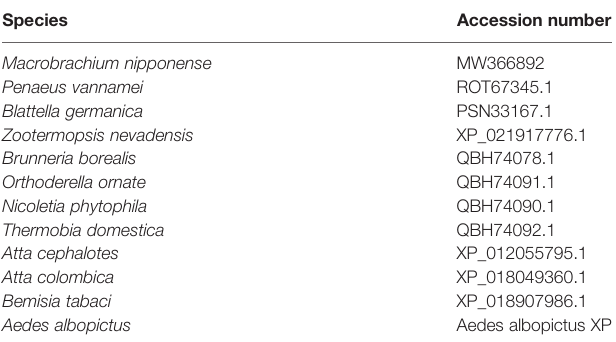
TABLE 2 | Species used for the construction of PDHE1 phylogenetic tree. Species